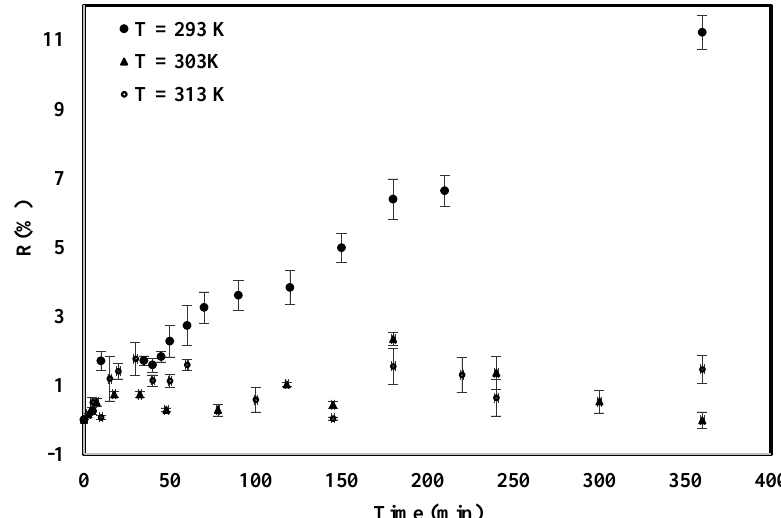
Figure 9. Effect of time on MO removal efficiency (R%) at different temperatures. ( A ) Effect of time on adsorption capacity (q); ( B ) Effect of time on removal efficiency (R%).